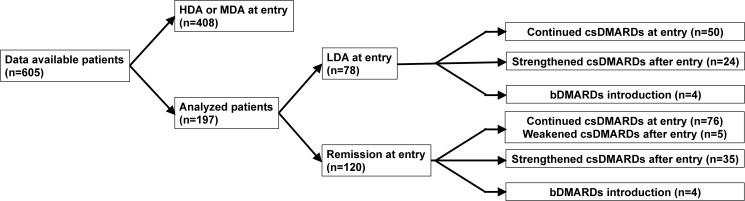
Patient enrollment flow chart and the therapeutic course during the 1-year observation after the baseline in our RA cohort.HDA: high disease activity; MDA: moderate disease activity; LDA: low disease activity; csDMARDs: conventional synthetic disease-modifying antirheumatic drugs; bDMARDs: biological disease-modifying antirheumatic drugs.